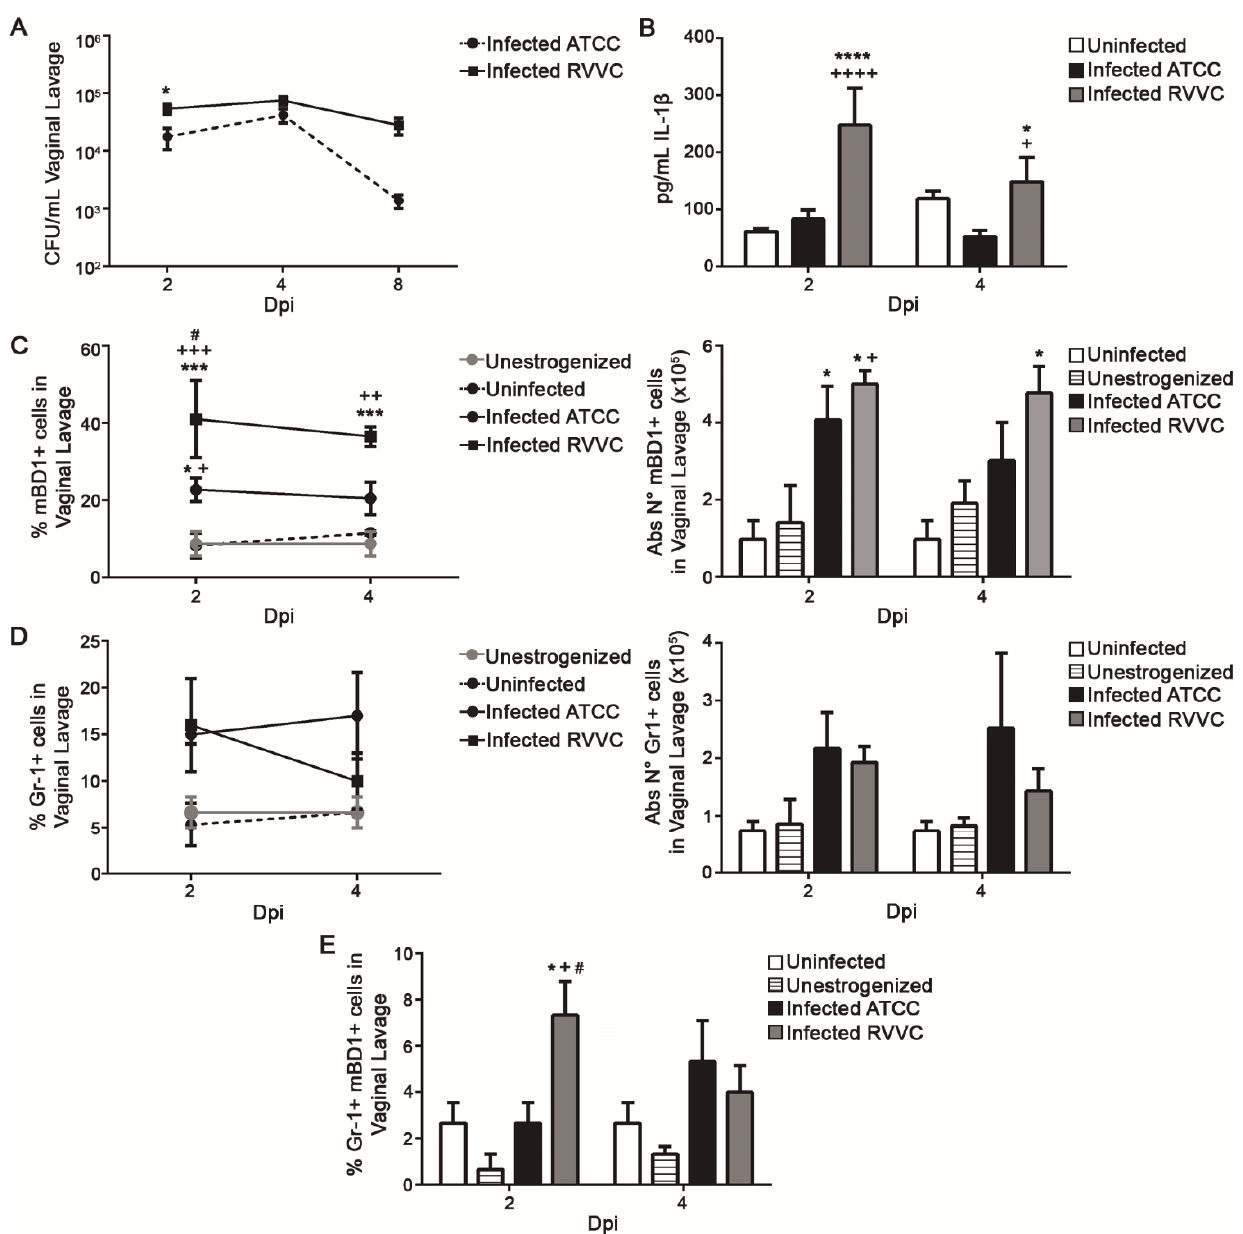
Figure 2. Differential expression of mouse Beta Defensin-1 (mBD1) during AVVC induced with C. albicans clinical or col- lection strains. ( A ) Fungal growth (CFU ± SEM) at days 2, 4, and 8 pi in vaginal lavage of C57BL/6 mice infected i.v. with 5 × 10 6 cells of C. albicans ATCC 36801 or C. albicans RVVC. Mean ± SEM of three independent experiments ( n = 8 per group). * p < 0.05. ( B ) IL-1 β levels in vaginal lavage from uninfected and C. albicans ATCC- or C. albicans RVVC-infected